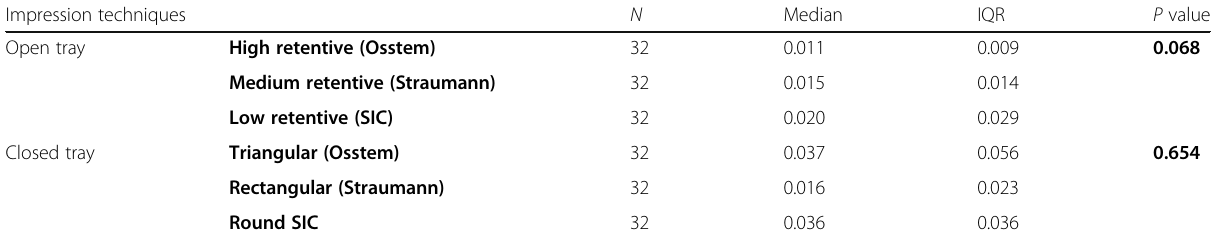
Table 1 Horizontal measurement in the open and closed tray impression techniques Impression techniques